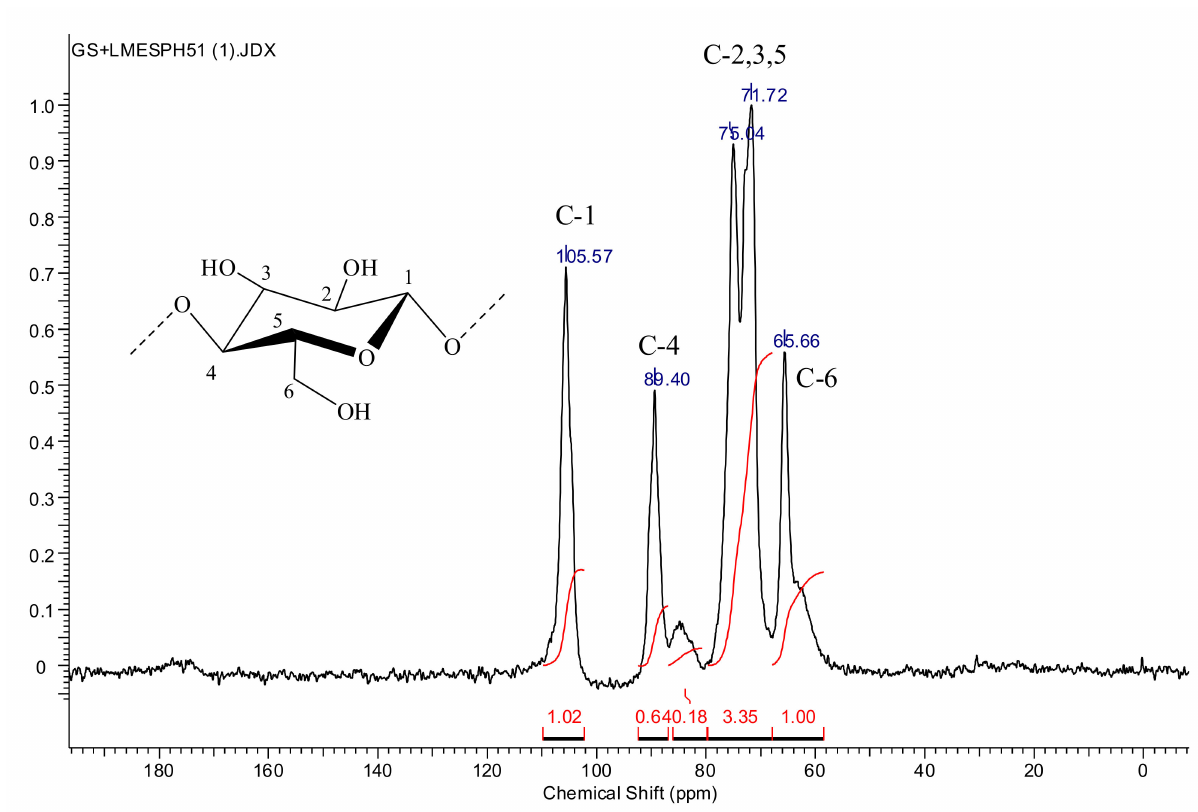
Figure 5. 13 C NMR spectra of